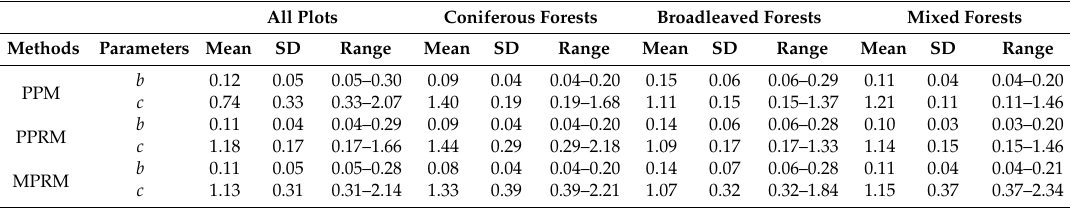
Table A4. Summary statistics of predicted b and c by three Weibull parameter prediction methods. All Plots Coniferous Forests Broadleaved Forests Mixed Forests